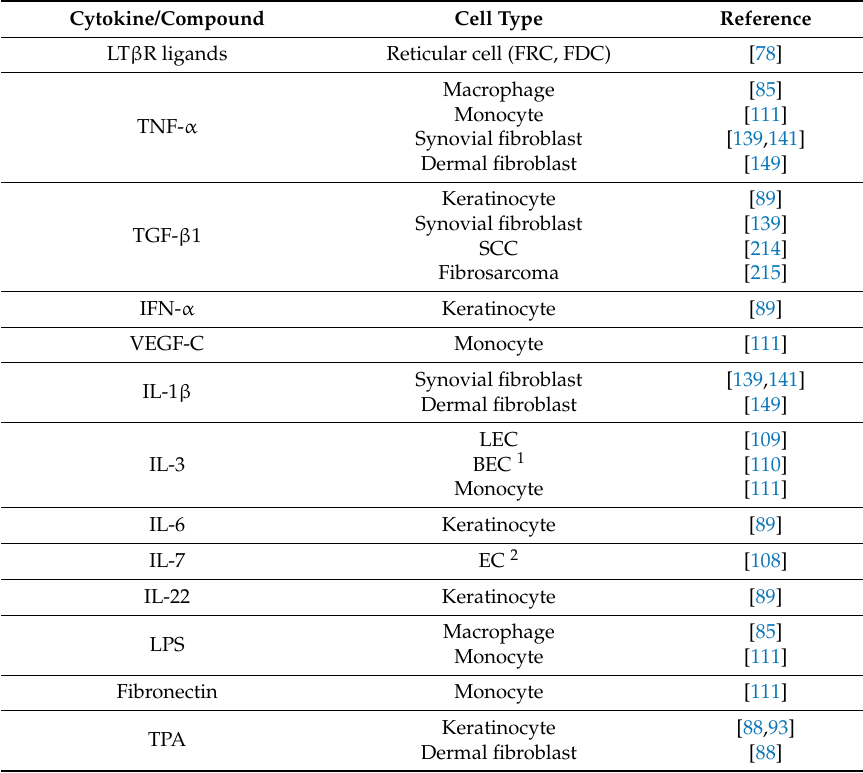
Table 3. Cytokines and other compounds stimulating podoplanin